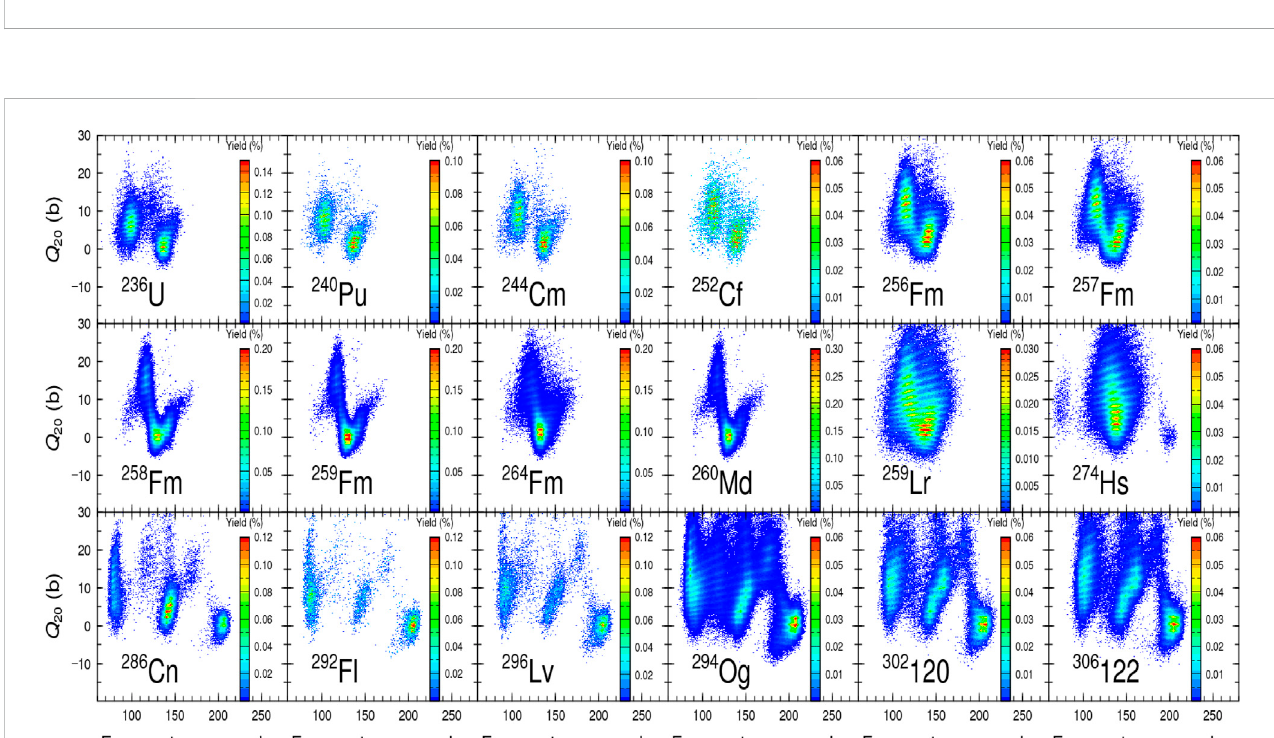
FIGURE 5 Quadrupole moment ( Q 20 ) distributions of 236 U to 306 122 at low excitation energy just above their fi ssion barrier height using the four-dimensional Langevin model.